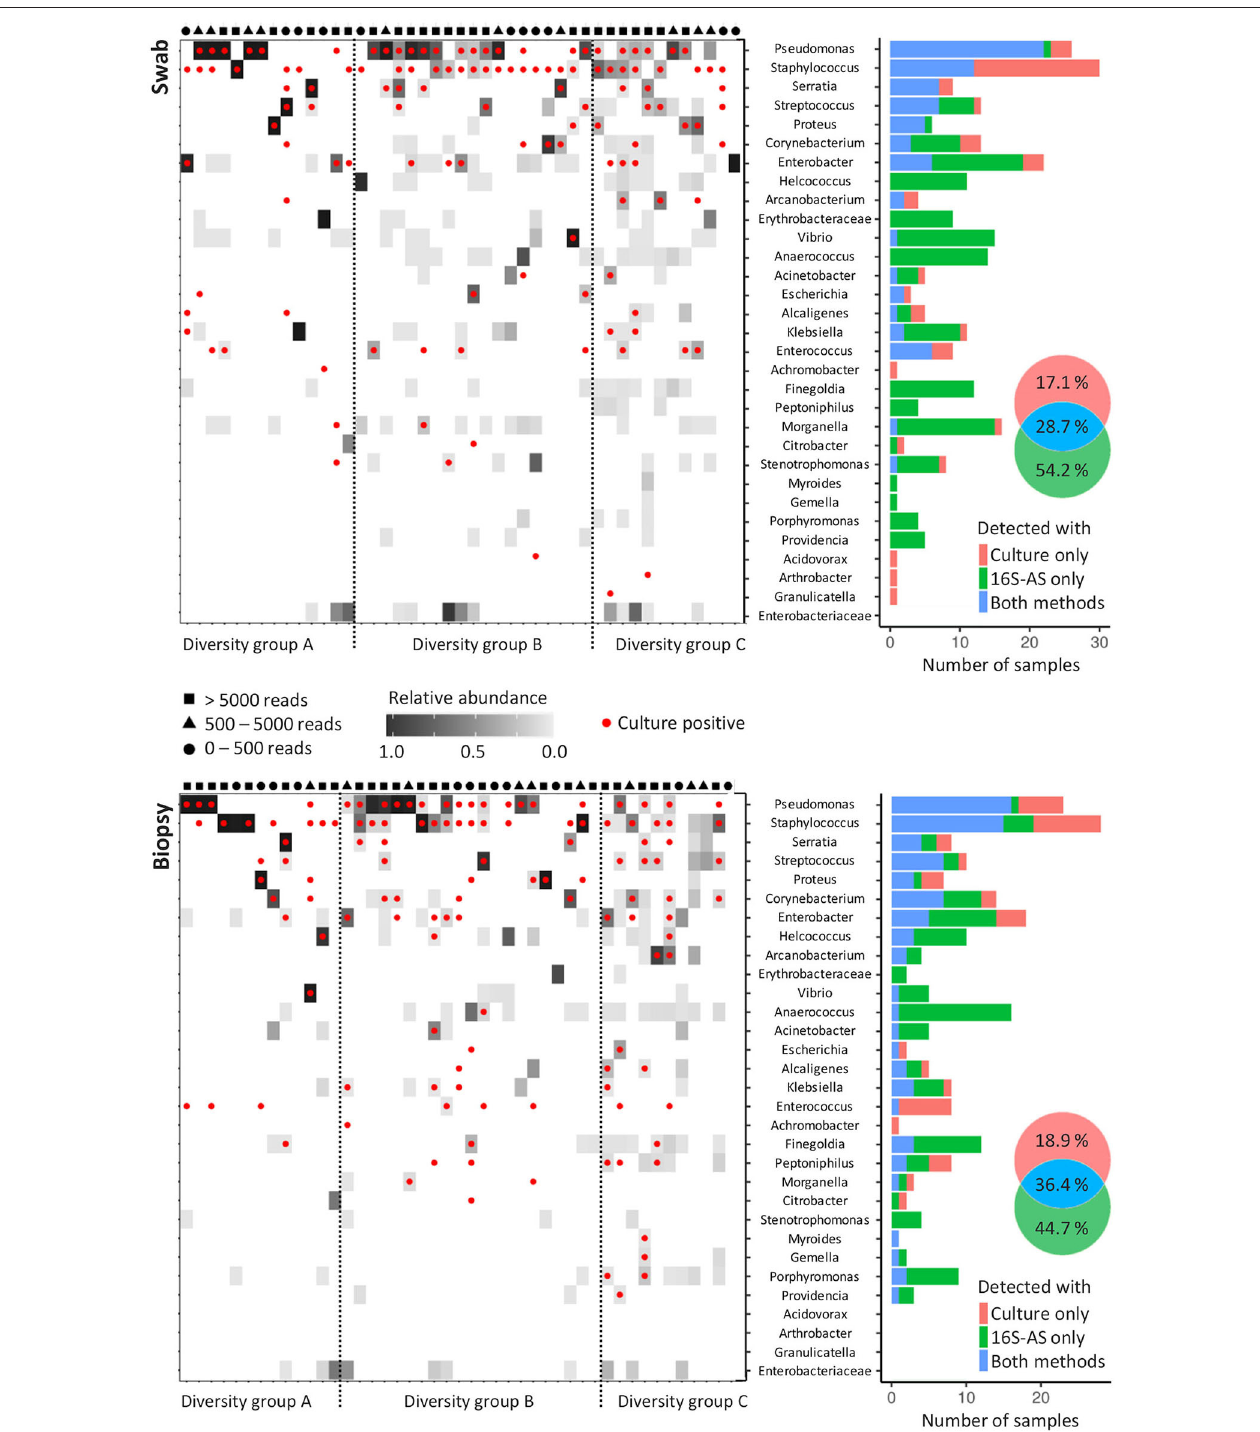
FIGURE 2 | Concordance in the detection of bacterial genera with cultivation and 16S-AS in chronic wounds. Heat-plots show relative abundances of bacterial genera across all analyzed CW samples obtained from swabs (top) and biopsies (below). Red dots denote genera, which were also detected with cultivation-based approach. Samples were assigned to three diversity groups (A, B, and C), based on the number of operational taxonomic units (OTUs) that were required to cover 99% of total obtained sequencing reads. Diversity groups were not associated with the number of reads obtained per sample, indicated by the symbols shown above the heat-plots approximating the number of reads per sample into three categories. Histograms (right) show the concordance between cultivation-based detection and 16S-AS. Venn diagrams show cumulative percentages for all detected bacterial genera.